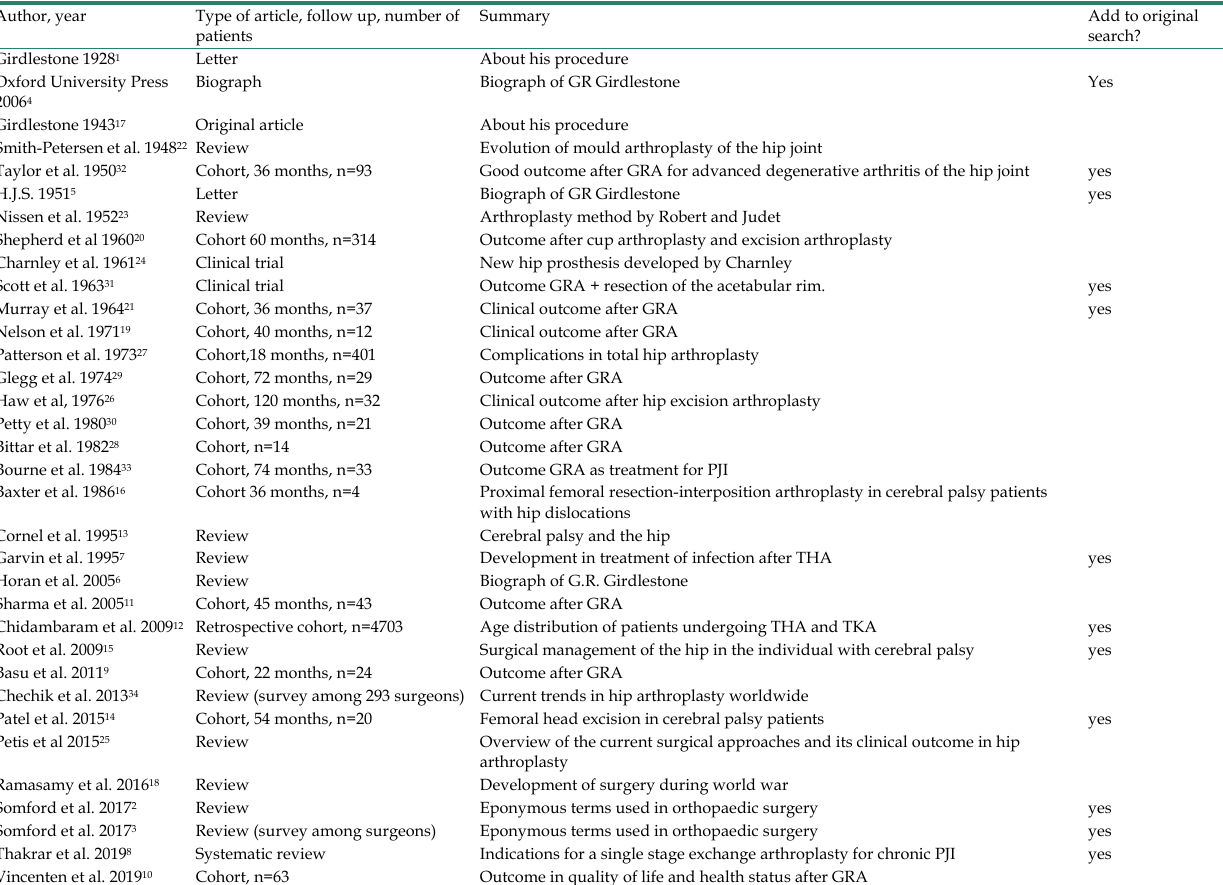
Table 1: Summary of articles used in this paper. Author,